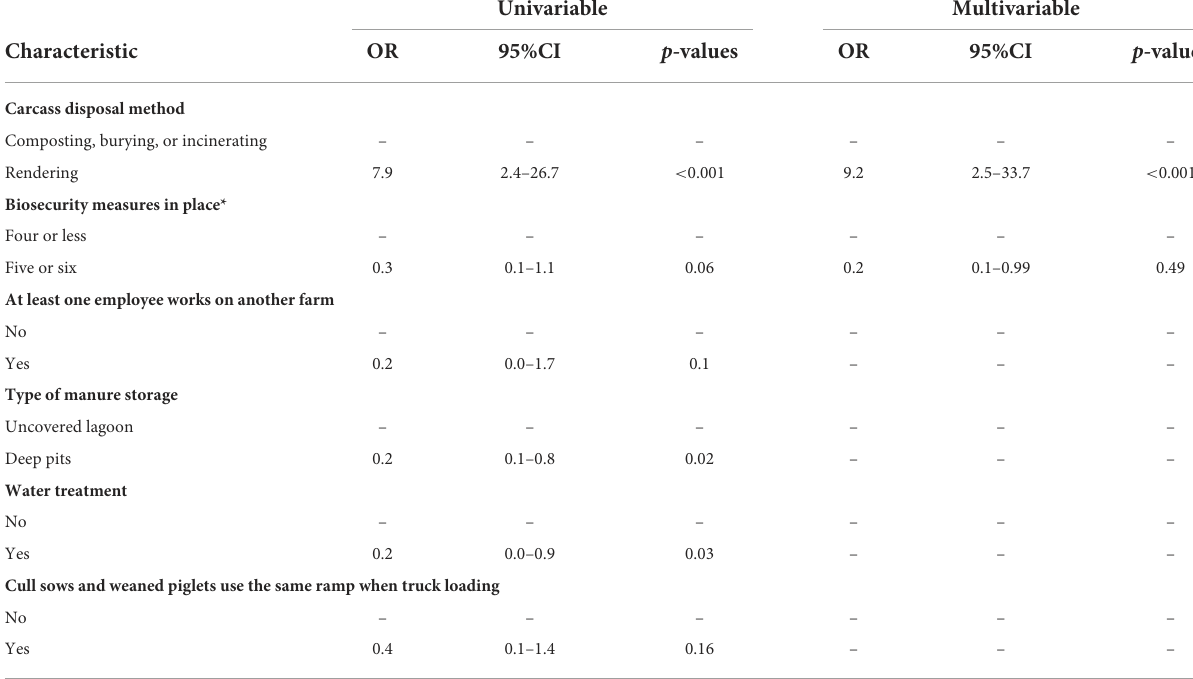
TABLE 2 Univariable and multivariable logistic regression analysis of the risk factors associated with SVA seropositivity in U.S. breeding farms. Univariable Multivariable Characteristic OR 95%CI p -values OR 95%CI p